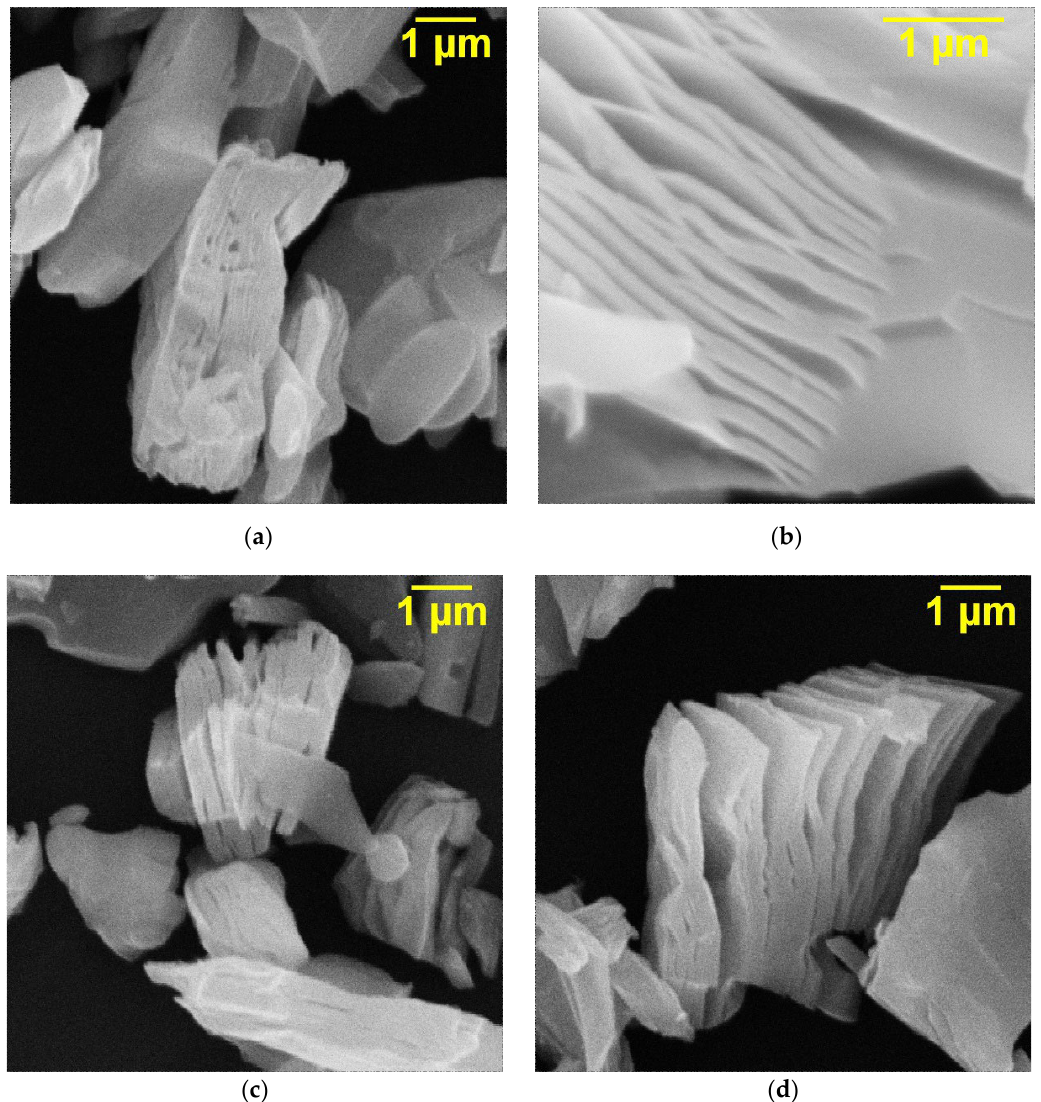
Figure 2. SEM images of ( a , b ) Ti 3 C 2 T x MXene and Ti 3 C 2 T x MXene intercalated with ( c ) DMSO and ( d ) urea molecules.